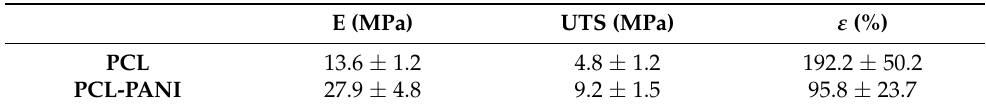
Table 2. Mechanical properties of PCL and PCL-PANI mats: Young’s modulus (E), ultimate tensile strength (UTS), strain at failure ( ε ).